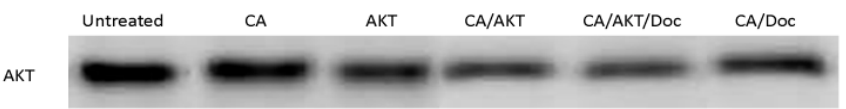
Figure 4. AKT protein expression in MCF-7 cells. Cells were treated with media (untreated), carbonate apatite, free AKT siRNA, CA/AKT siRNA, CA/AKT/Doc, and CA/Doc. Ingredients include 3 mM of CaCl 2 , 1 nM siRNA, and 1 nM Doc. Cellular lysates were run in SDS-PAGE and transferred into PVDF membrane and incubated with primary antibodies raised in rabbit against AKT. HRP-conjugated goat anti-rabbit secondary antibody was used to detect the chemiluminescent signals.